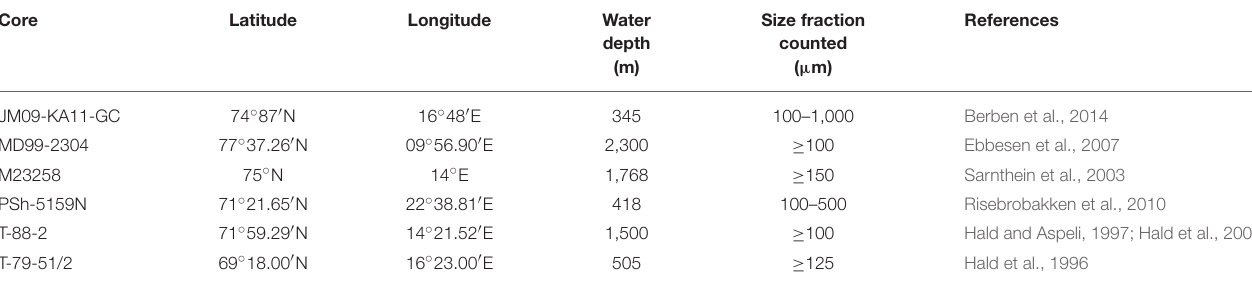
TABLE 1 | Names of cores sites, geographic locations, water depths, and references to the first publication of the synthesized data. Core